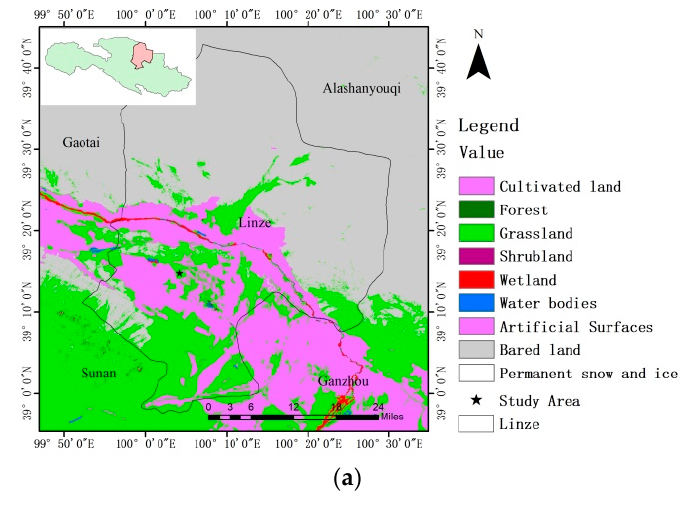
Table 1. Summary of the approaches in related